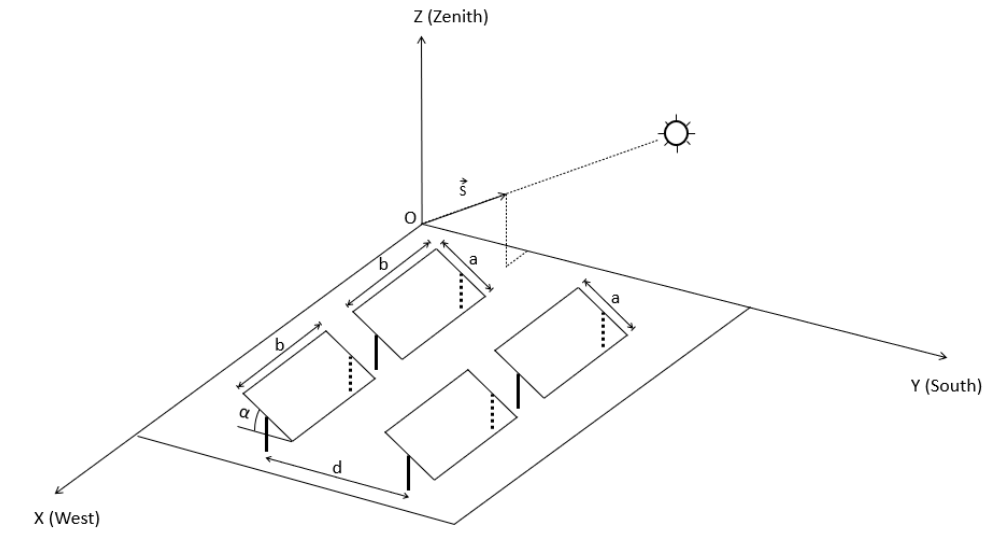
Figure 1. Geometric characterization of the considered PV installations.